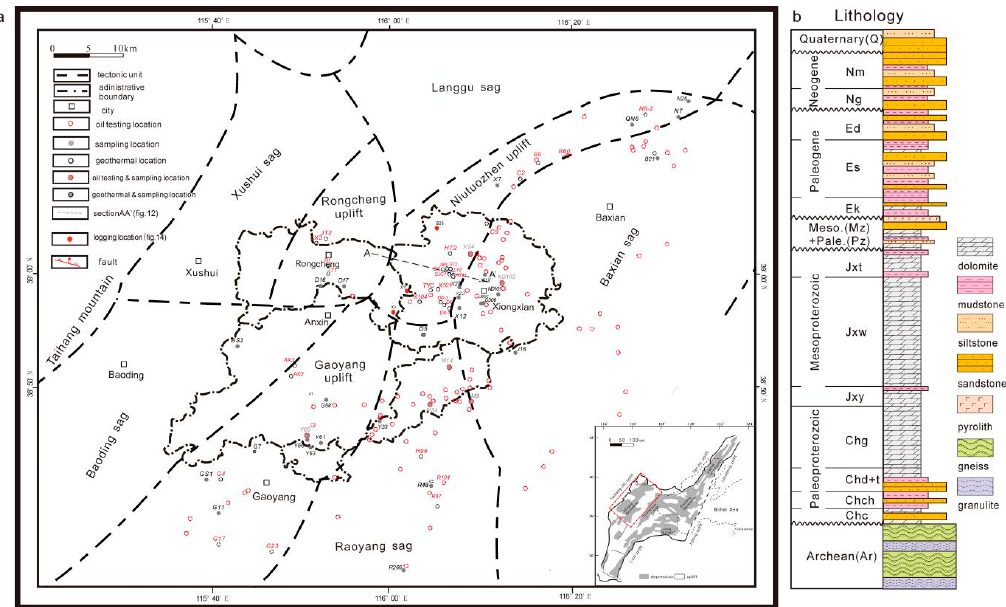
Figure 2. Tectonic and well locations ( a ) and stratigraphy ( b ) of the Xiong’an New Area.Geological structure and distribution of sampling points and well locations in Xiong’an New Area ( a ); The main lithlogic stratigraphy column in Xiong’an New Area ( b ).